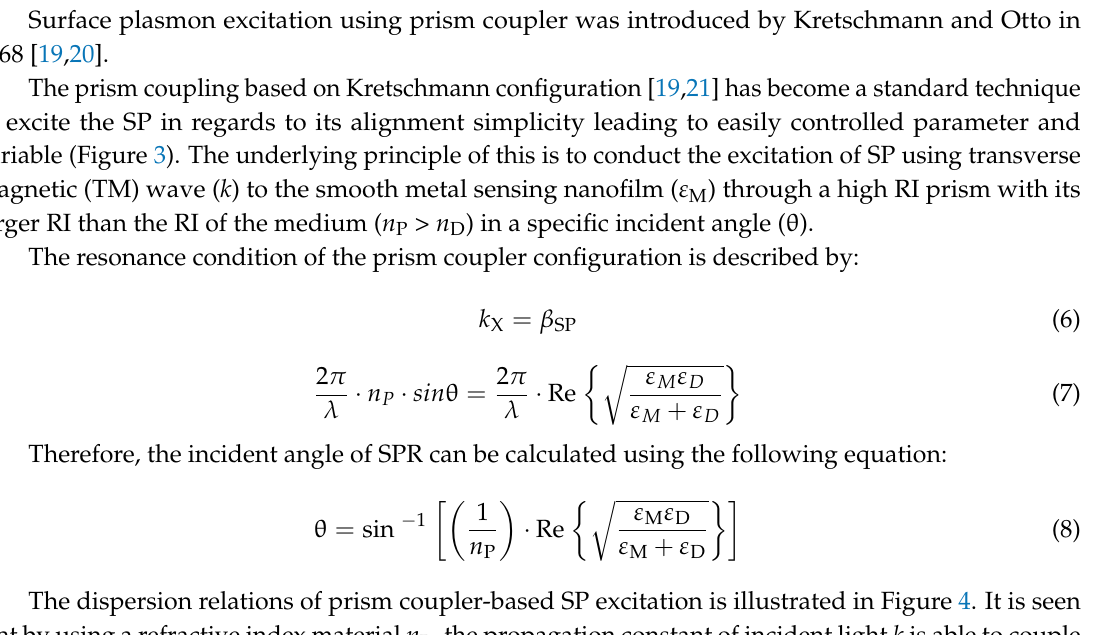
Figure 3. SPR excitation by prism coupling using Kretschmann configuration.